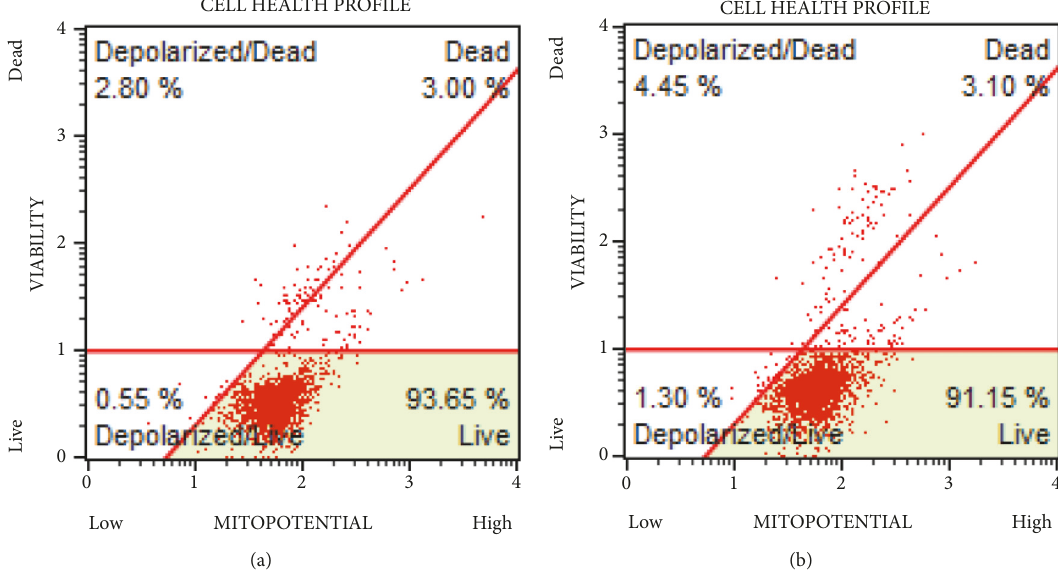
Figure 5: 4,5-diCQA does not induce depolarization of mitochondrial membrane potential in DU-145 cells . The MUSE Mitopotential assay for the control (a) and the treated (b) was compared. The treated group consisted of cells with 5 𝜇 M (IC 50 ) of 4,5-diCQA for 72 hours, after which both groups were analyzed using a MUSE flow